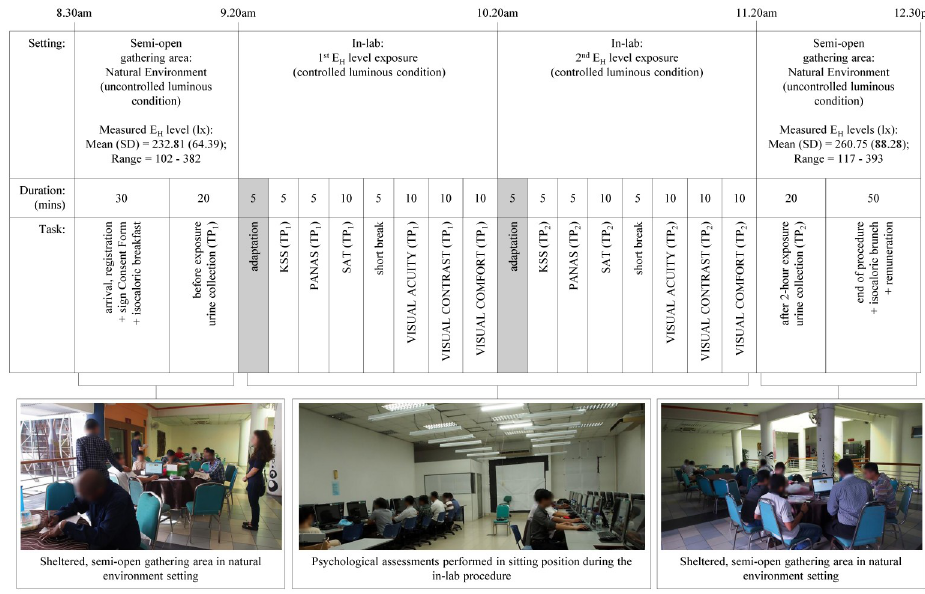
Fig 4. Details of the experimental procedure for each